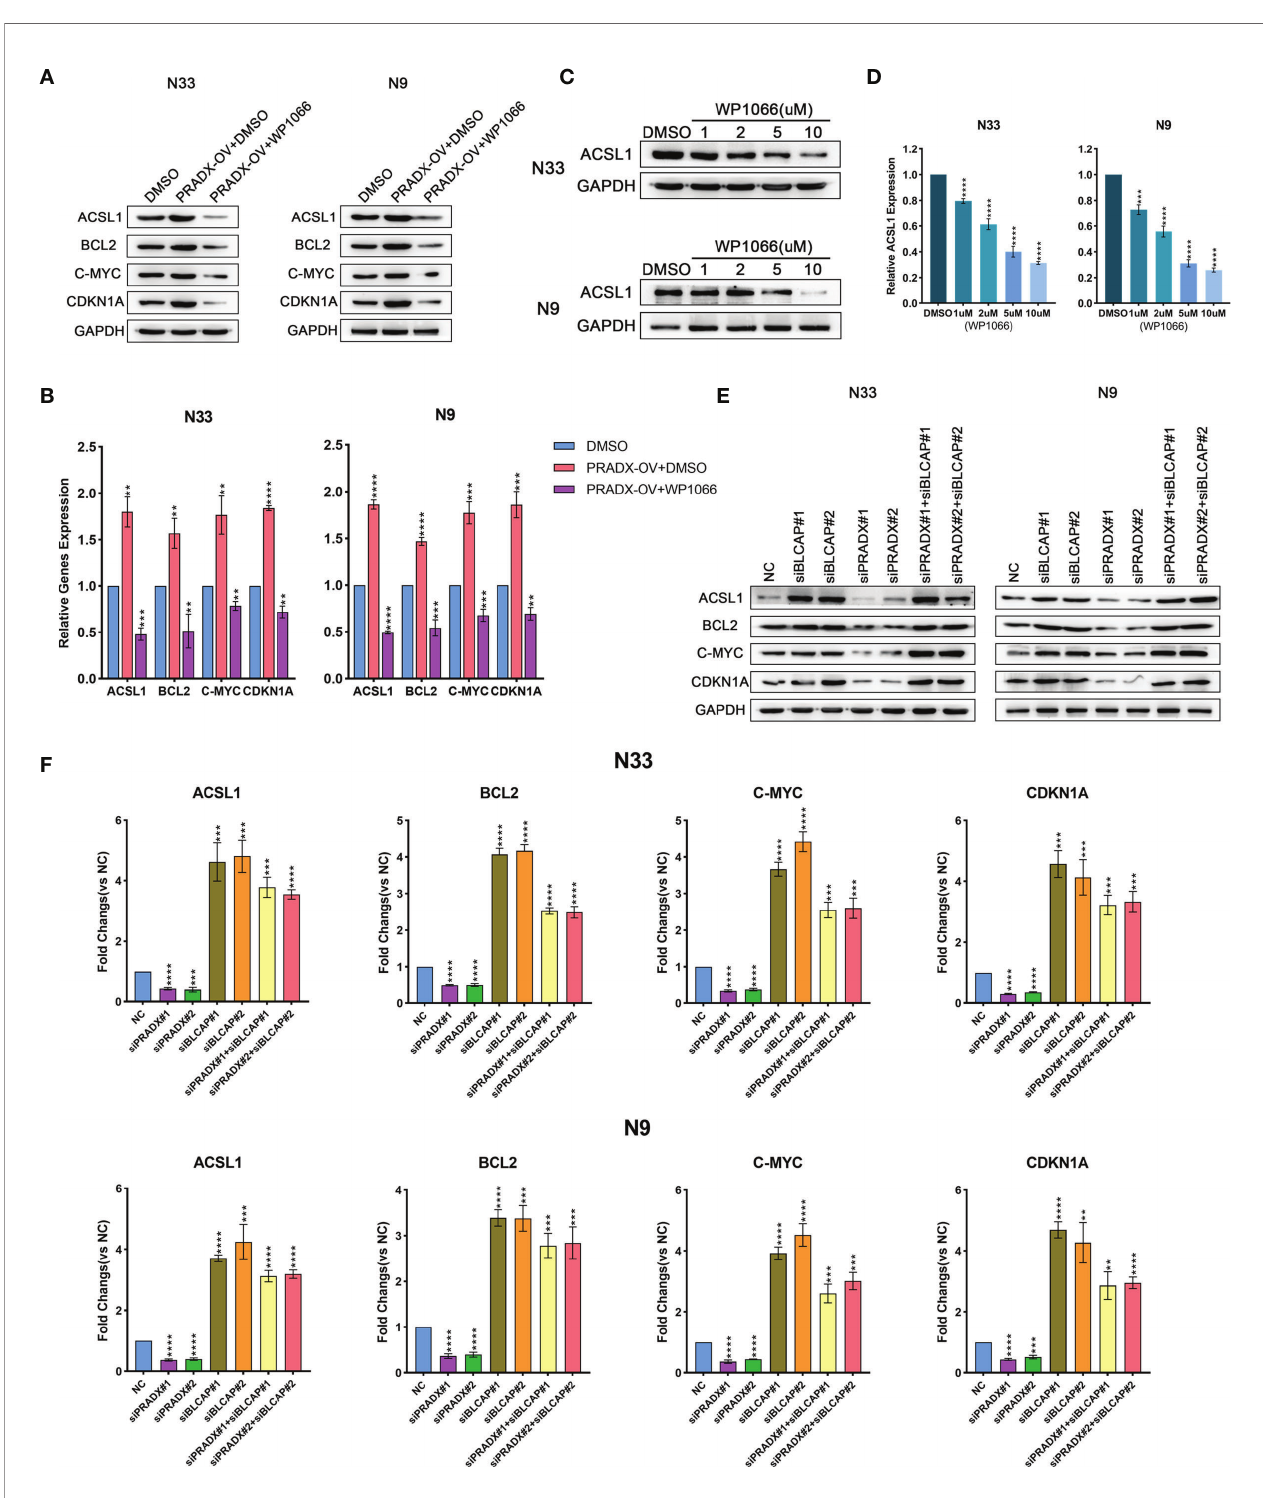
FIGURE 5 | PRADX activates the STAT3 pathway via suppressing BLCAP. (A, B) qRT-PCR and western blotting analyses showing ACSL1, BCL2, c-MYC, and CDKN1A mRNA and protein expression levels in PRADX overexpressed, PRADX overexpressed plus WP1066 and DMSO groups. (C, D) qRT-PCR and western blot analysis showed WP1066 treatment decreased ACSL1 mRNA and protein levels in a dose-dependent manner. GAPDH served as a positive control. (E, F) qRT- PCR and western blot analyses demonstrating ACSL1, BCL2, c-MYC, and CDKN1A mRNA and protein expression levels in BLCAP and/or PRADX knockdown and NC groups. The values in (B, D, F) are represented as mean ± SD (n = 3). **P < 0.01, ***P < 0.001, ****P